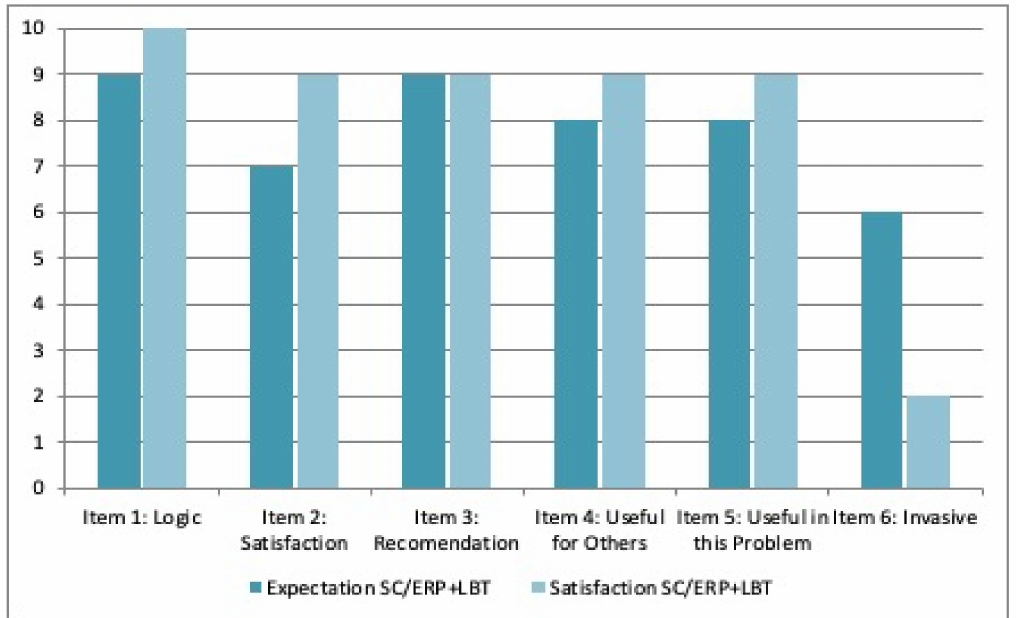
Figure 5. Expectation and satisfaction with the SC/ERP + LBT-based ICT system by patient 1.